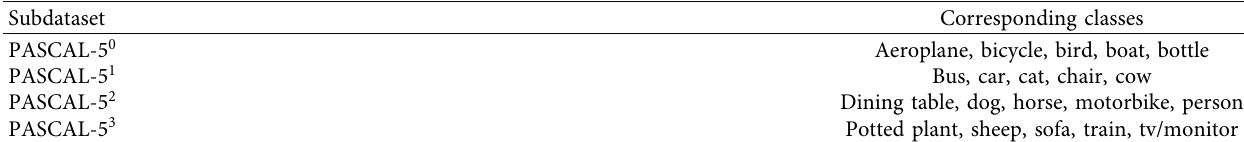
Table 1: The detailed splitting of Pascal Voc 2012 dataset.